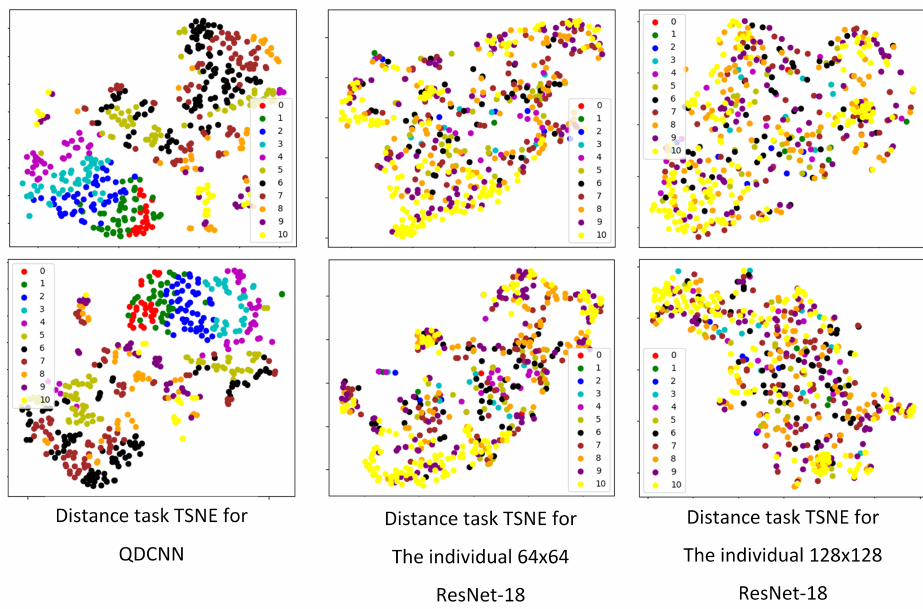
Figure 11. Examples of t-SNE graphs of the feature vectors from the QDCNN, the 64 × 64 pixels ResNet-18, and the 128 × 128 pixels ResNet-18 for the distance